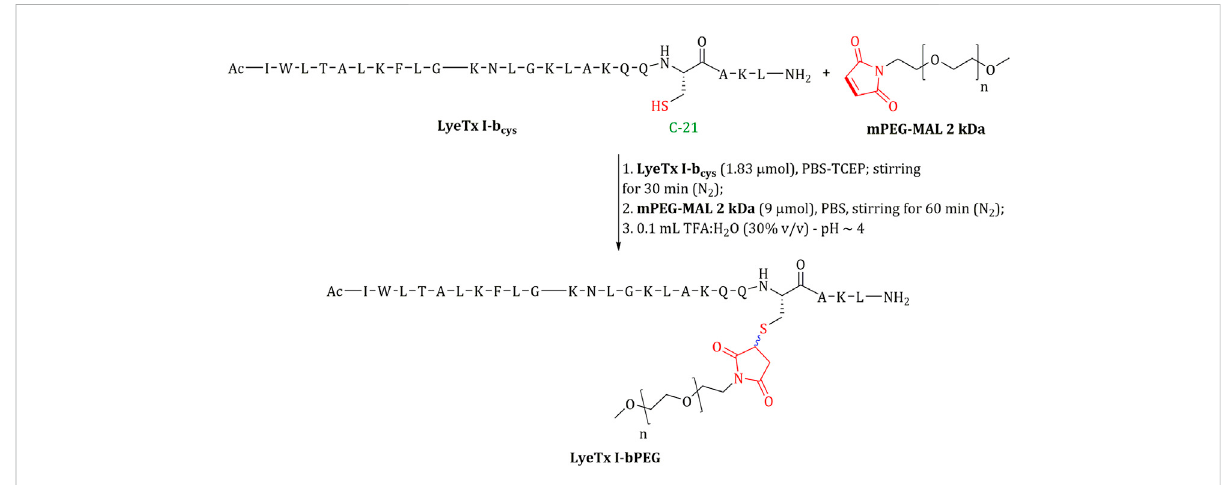
Schematic presentation of the conjugation between LyeTx I-b cys and mPEG-MAL to afford LyeTx I-bPEG. Directly involved groups are shown in